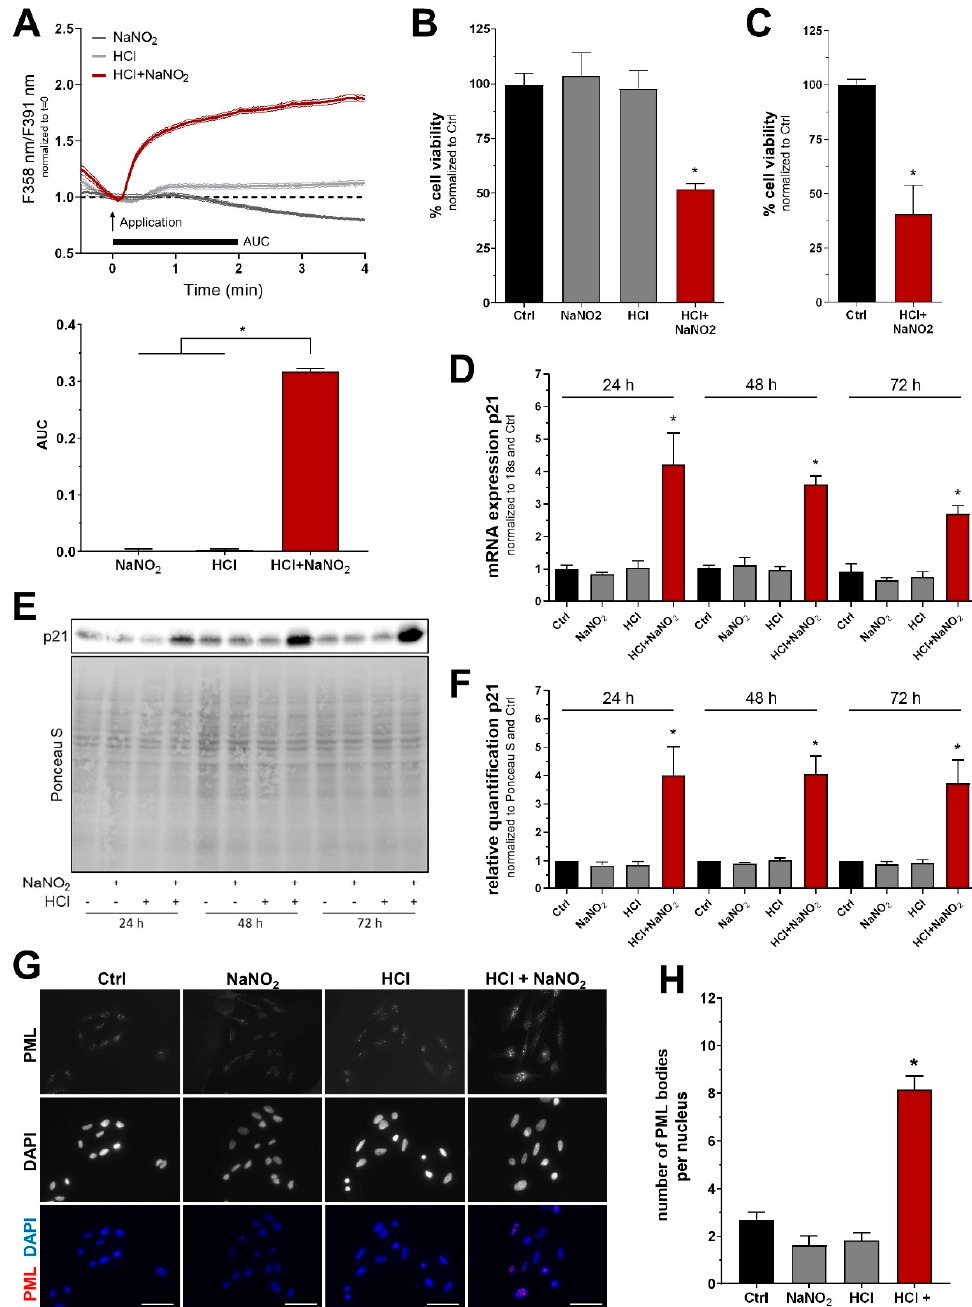
Figure 2. Nitrite and acidification have synergistic effects on melanoma cells. ( A ) Time course of cytoplasmic Ca 2+ levels due to a 4-min treatment with acidic ECS (HCl), nitrite solution (NaNO 2 ), or a combination of both. Ca 2+ levels were quan- tified by calculating the area under the curve (AUC) of the first 120 s after the start of the application (F (2,828) = 1891, p <0.0001, n = 260–293). ( B ) Cell viability analysis 24 h after a 5 min treatment with untreated ECS (Ctrl) or solutions described in ( A ) (F (3,8) = 10.93, p = 0.0033). ( C ) Cell viability analysis 24 h after a 5 min treatment with phosphate-buffered ECS without HEPES (Ctrl) or a combination of acidic phosphate-buffered ECS without HEPES and nitrite (Student’s t -test). ( D ) Expres- sion analysis of p21 during the time span of 24–72 h after treatment (F (11,24) = 13.82, p < 0.0001). ( E , F ) Western blot analysis and quantification of p21 protein levels with similar incubation time as ( D ) (F (11,24) = 10.44, p < 0.0001). ( G , H ) Immunofluo- rescent stainings of PML and DAPI to assess DNA damage. The amount of PML nuclear bodies was quantified in the bar chart (F (3,8) = 55.13, p < 0.0001). Scale bars: 50 µm. Traces are mean with 95% confidence interval, bars are mean ± SEM (ANOVA followed by Tukey’s HSD post-hoc test vs. Ctrl, n = 3, *: p < 0.05).